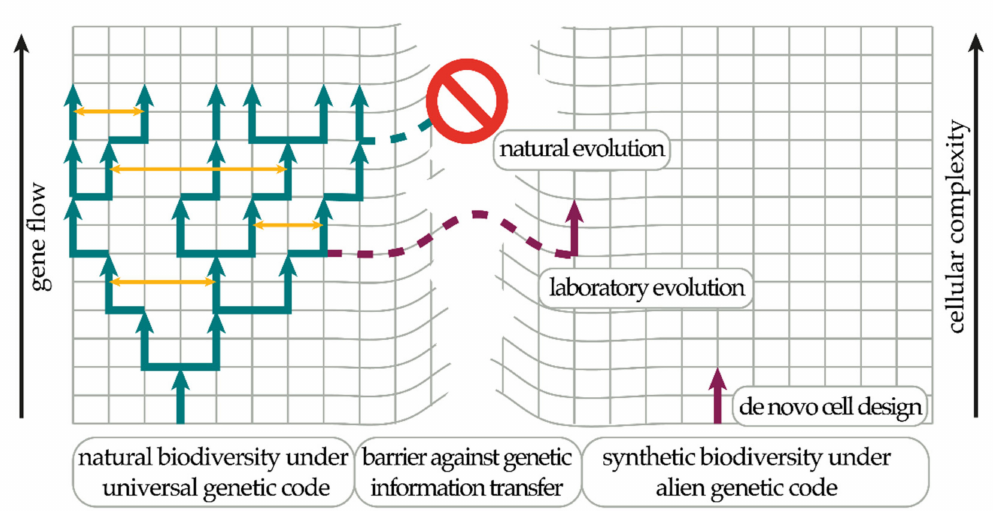
Figure 1. Biocontainment based on an alien genetic code. Life on Earth is a unity due to the existence of the universal genetic code. The exchange of genetic information from very different paths of evolution (horizontal gene transfer (HGT), yellow arrows) is facilitated by the universal genetic code fixing the basic core cellular chemistries (left side). Genetic information persists in time within a species through reproduction (vertical gene transfer (VGT), green arrows). A robust biocontainment system needs to restrict the flow of genetic information, which can be achieved through an alternative genetic code allowing for the exploration of drastically different cellular chemistries (right side). Currently, there are two promising experimental routes towards this goal: de novo (from scratch) cellular design (bottom-up) [30,31] or the successive alienation of a complex natural organism through laboratory evolution (top-down)